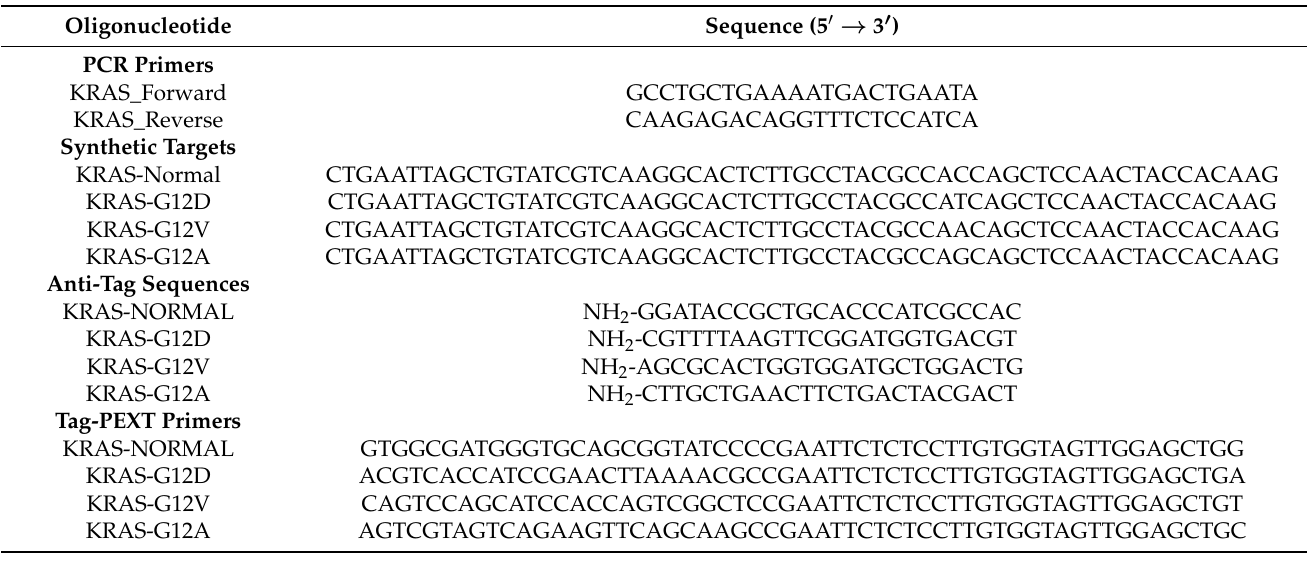
Table 1. Sequences of the PCR and PEXT primers, the synthetic DNA targets, and the anti-tag sequences attached onto the polystyrene